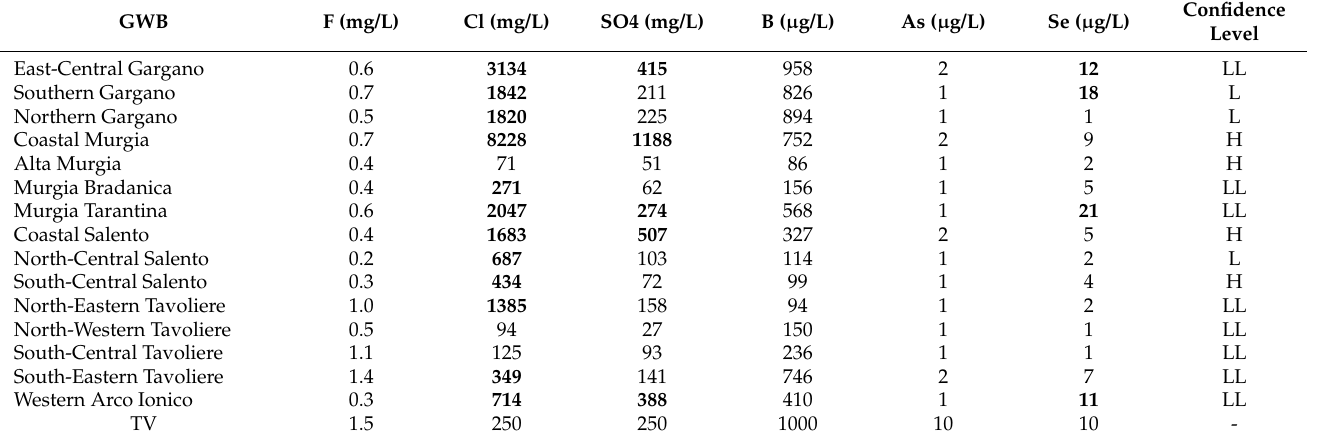
Table 6. Defined NBLs and associated confidence levels for the non-redox sensitive elements. NBLs above the threshold values are shown in bold. H = high; L = low; LL = very low. As indicated in the guidelines, the NBL for each parameter was expressed with the same measurement unit and rounded up with the same number of decimals as the relative TV set by Legislative Decree 152/2006.